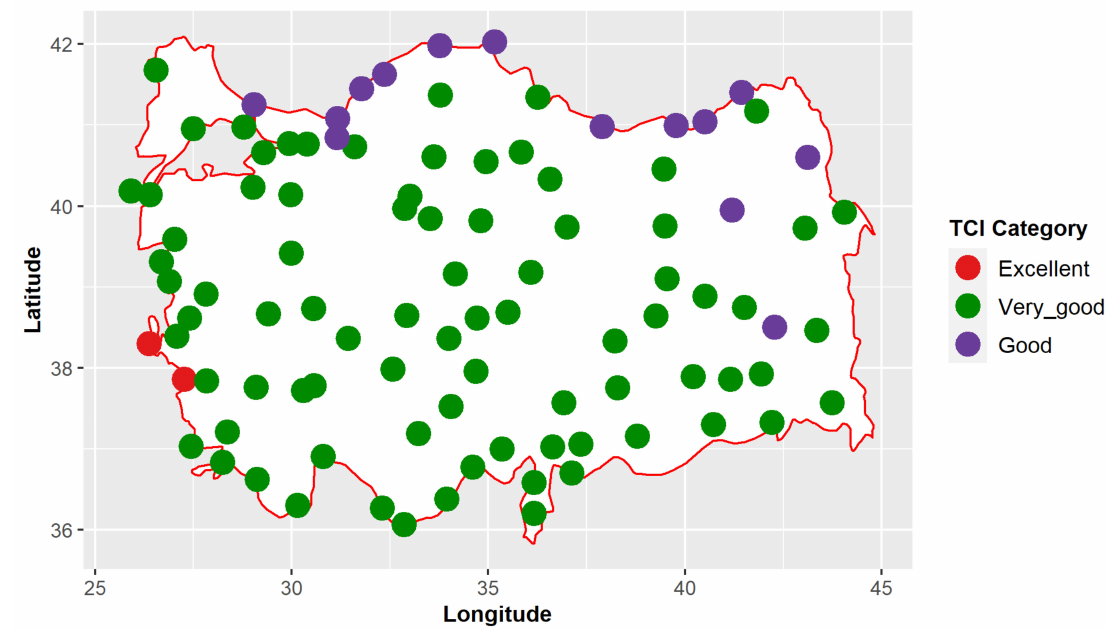
Figure 5. The TCI distribution for autumn.